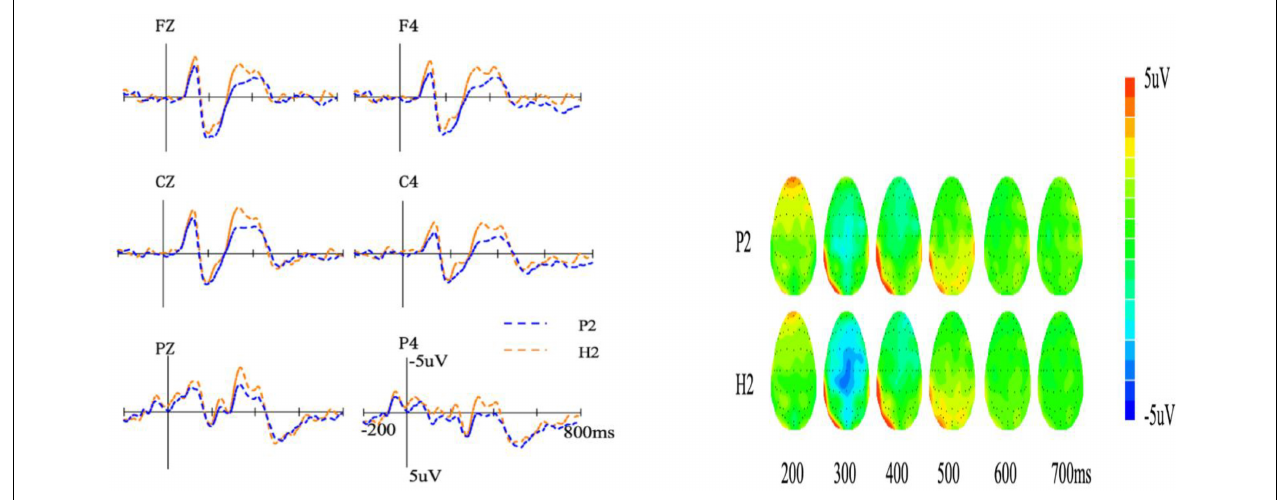
FIGURE 4 | Event-related potentials (left) and topography (right) of the two meaning types in session B. P2, the second meaning of polysemy; H2, the second meaning of